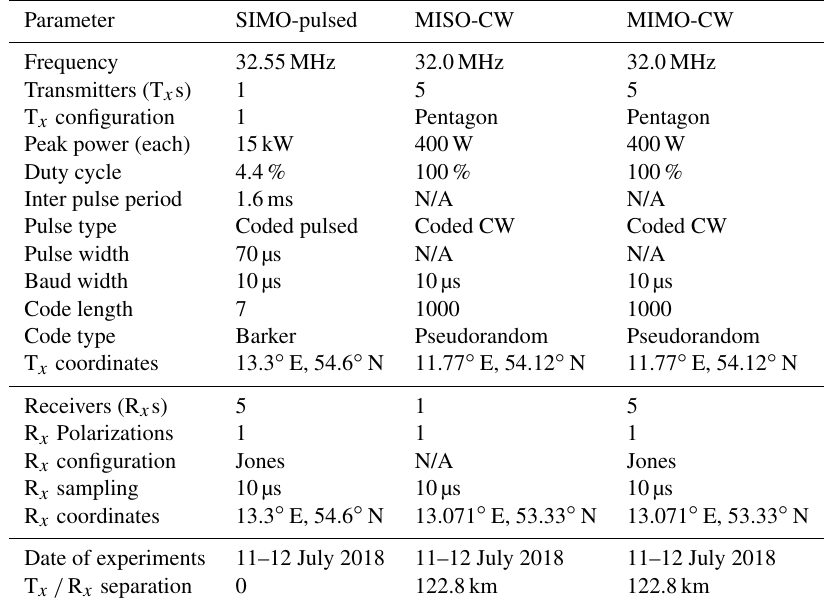
Table 1. Parameters for each SMR configuration.